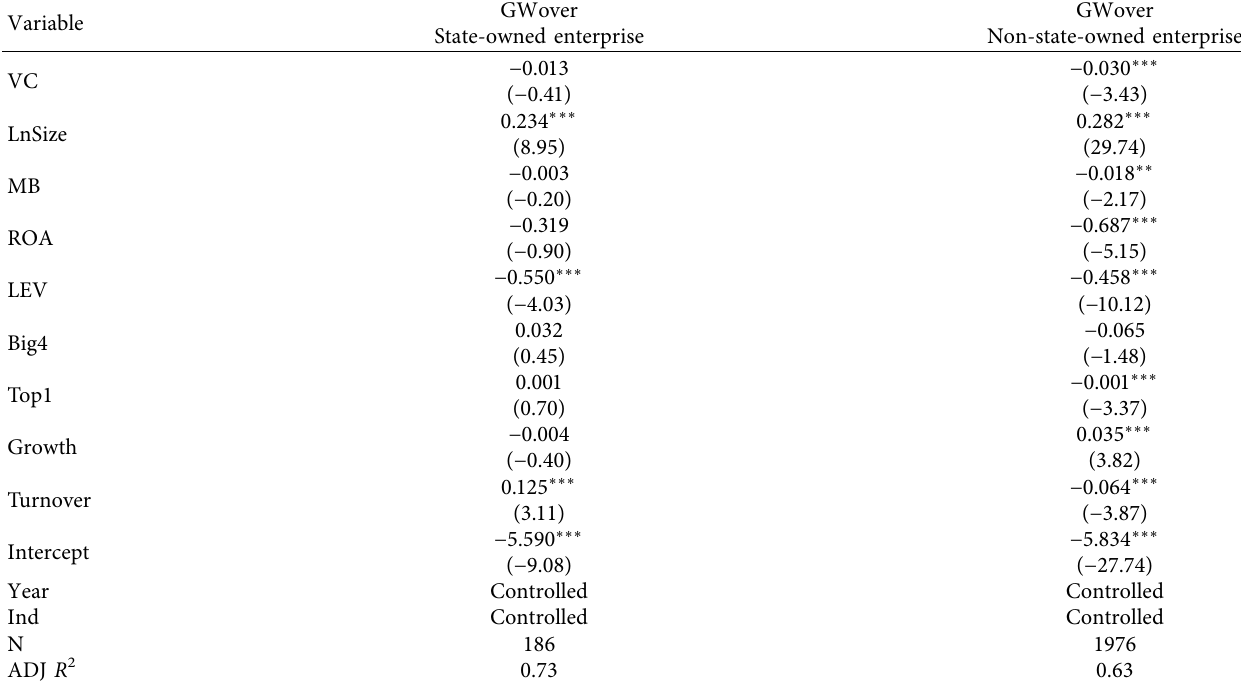
Table 11: Regression results of reducing information asymmetry.